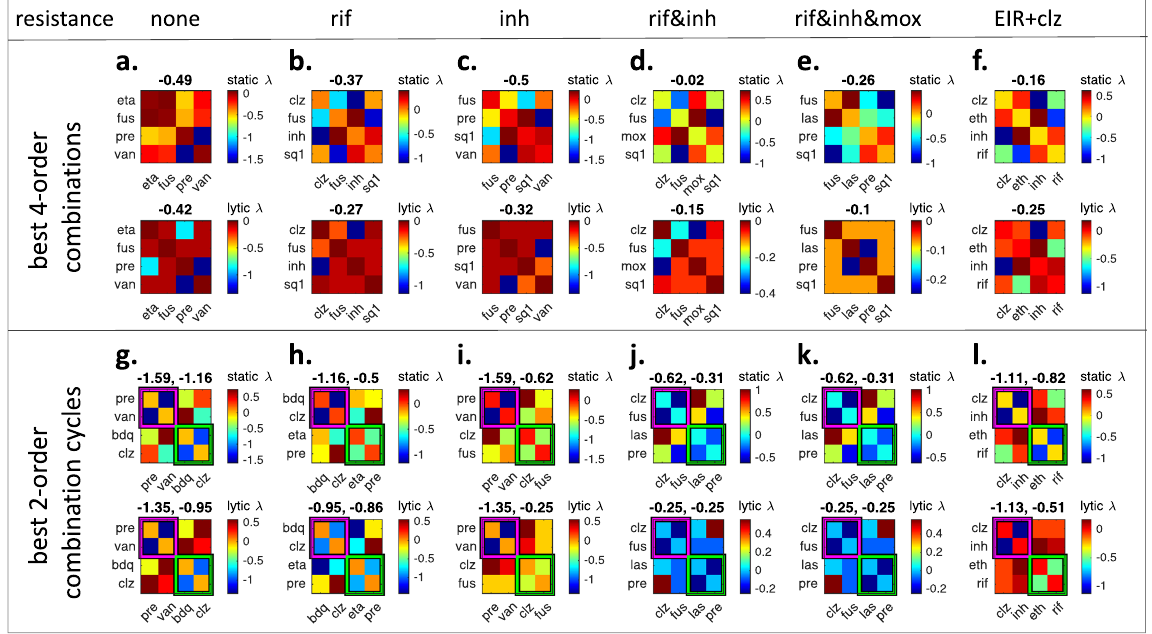
Figure 5. Exploring best 4-order combinations and 2-order drug cycling options against drug-resistant M. tuberculosis . In each panel, all pairwise static λ and lytic λ scores among four drugs are given as heatmaps. (top) Heatmaps correspond to best 4-order combinations against drug sensitive or resistant M. tuberculosis. The scores above heatmaps indicate the estimated 4-order interaction scores. ( a ) eta + fus + pre + van is the lowest ranked 4-order combination in our framework. ( b ) Since rif and van are similar drugs, we cannot use van against a rif-resistant Mtb strain. Therefore, the lowest ranked 4-order combination shown in ( a ) is not applicable. When rif and van are excluded, the lowest ranking 4-order combination is clz + fus + inh + sq1. ( c ) Similarly, since inh and eta are similar drugs, we cannot use eta against an inh-resistant Mtb strain. The best 4-order combination against inh-resistant strain is found as fus + pre + sq1 + van. ( d,e ) The best 4-order combinations against Mtb strains resistant to rif-inh or rif-inh-mox. ( f ) The best 4-order combination that includes current Mtb treatment. (bottom) Magenta and green frames show the 2-order combinations nominated for cycling. The two scores correspond to measured static λ and lytic λ scores for each pairwise combination. ( g ) Best 2-order combination cycling is pre + van and bdq + clz. ( h – k ) Best 2-order cycling options for Mtb strains resistant to indicated drugs. ( l ) When considered as two 2-order combinations, EIR + clz is split into clz + inh and eth + rif. For each resistance scenario and EIR + clz, the static λ and lytic λ scores in cycling is superior to 4-order